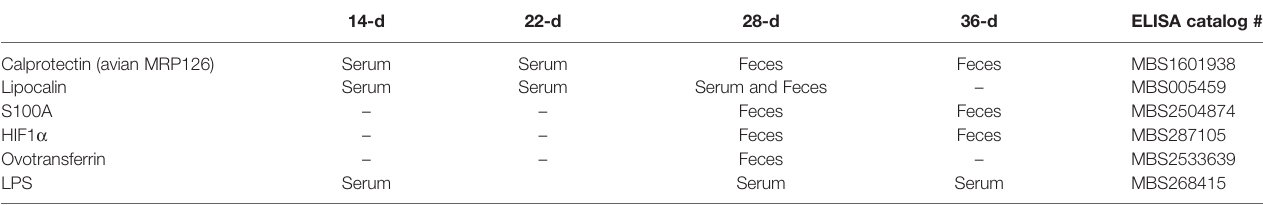
TABLE 3 | Proteins quanti fi ed in serum and/or feces of broilers at 14, 22, 28 or 36 days post-hatch by